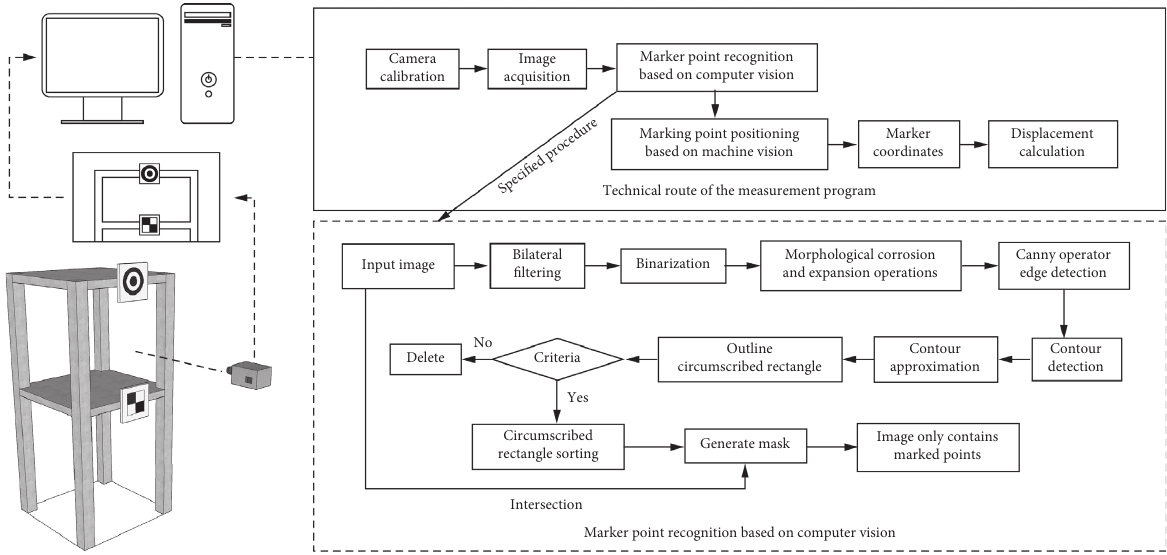
Figure 1: Technical route of them easurement program.